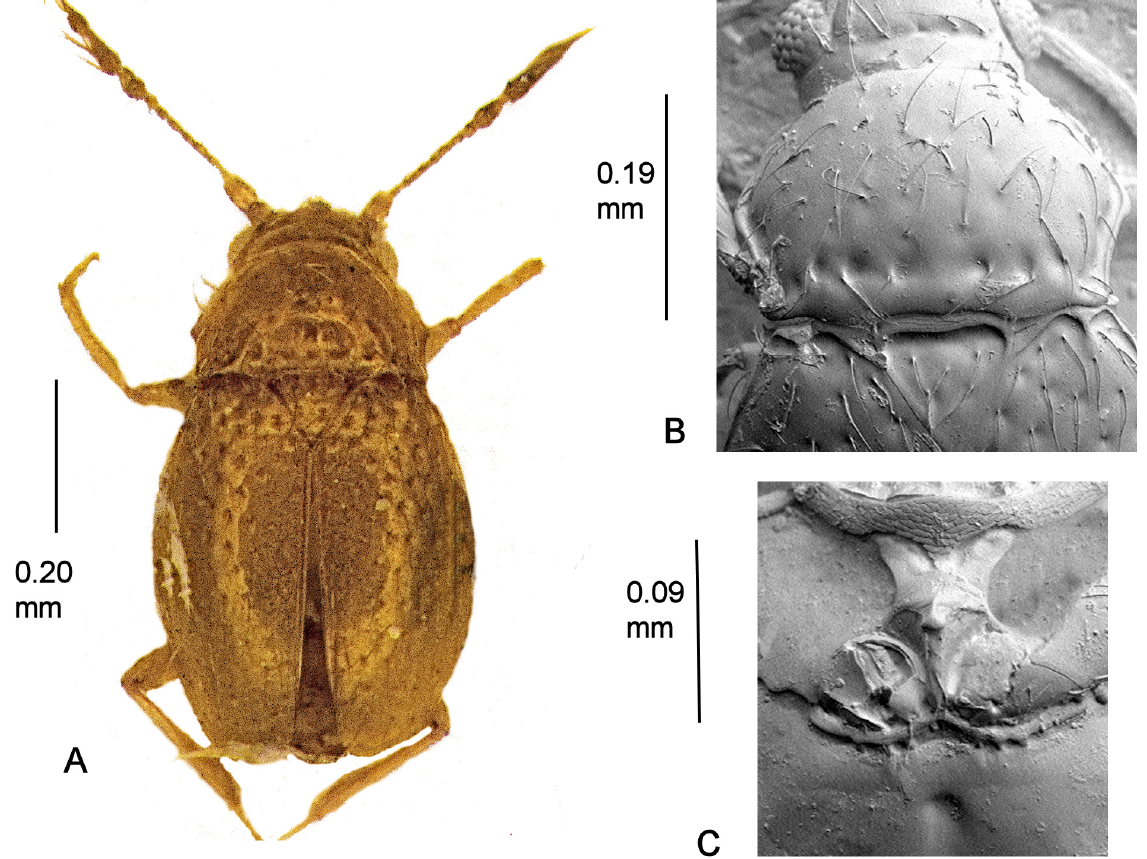
Fig. 25 . Cissidium greensladei sp. nov. A . Habitus. B . Pronotum, × 565. C . Mesoventrite showing median process of collar, mid-keel and keel, ×